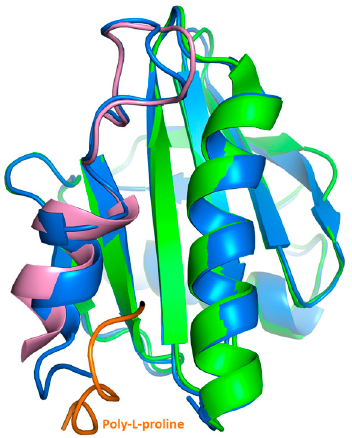
Figure 5. Superimposition of crystal structures of ragweed profilin (Amb a 8) alone (apo) and in complex with poly-( L -proline) 10 ligand. The apo (pdb 5EM1) and complex (5EVE) structures of Amb a 8 are presented in blue and green, respectively. Poly-( L -proline) peptide is highlighted in orange, while the N-terminal segment, which undergoes an induced fit upon binding, was highlighted in pink.